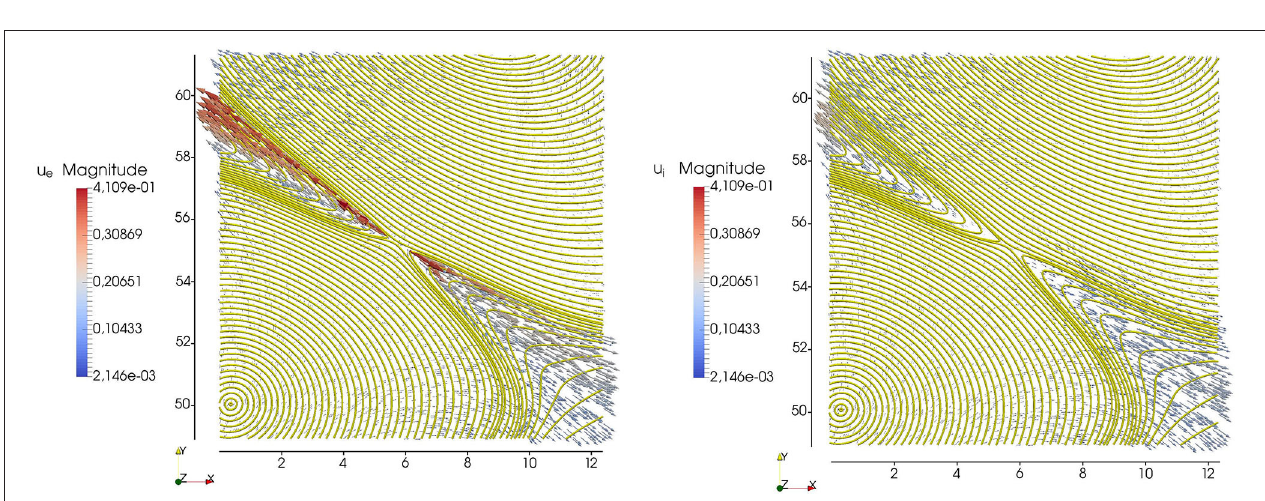
FIGURE 5 | (Left) From sim.A. Shaded iso-contours of (minus) the out-of-plane electron flow, y -component of the electron and ion flow, u e, y and u i, y (bottom left and bottom right, respectively) in a zoom-in region one-fourth the size of the simulation domain at t 114 (cid:127) − 1 i . (Right) From sim.B. Shaded iso-contours of (minus) the out-of-plane electron flow, = the x -component of the electron and ion flow, u e, x and u i, x (bottom left and bottom right, respectively) in a zoom-in region one-fourth the size of the simulation domain at t 203 (cid:127) − 1 i . ≈